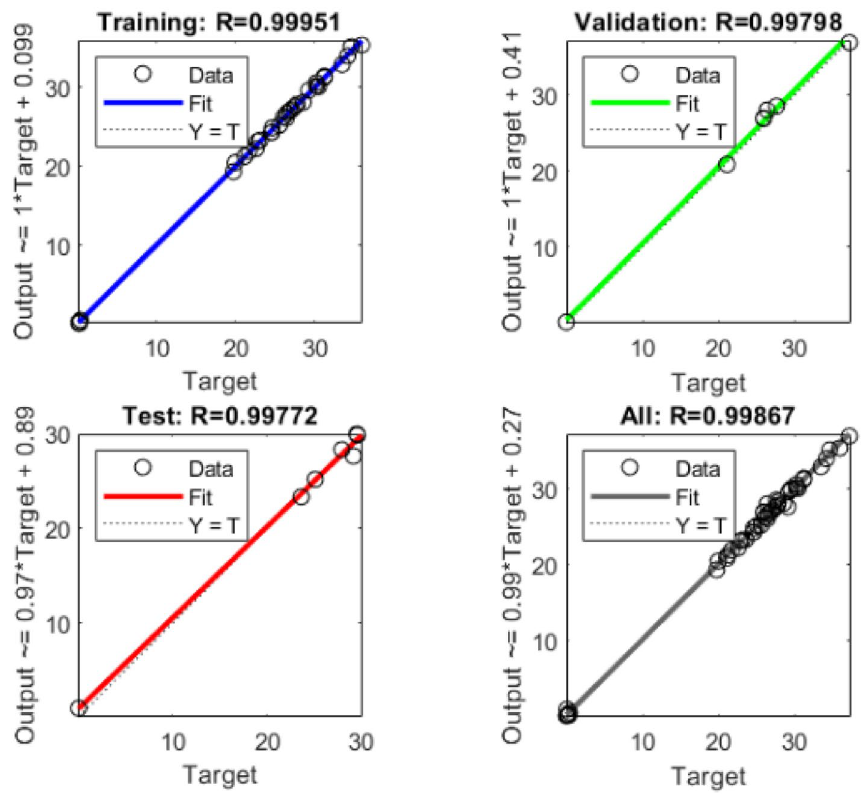
Figure 8. The output of the 2–10–1 ANN concerning the target value for the training, validation, testing and all the data